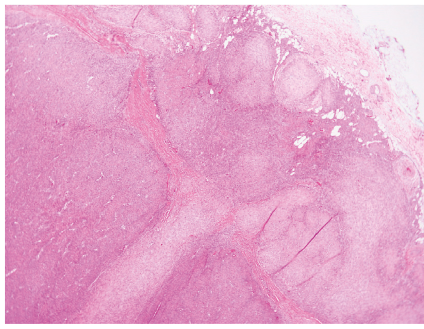
Figure 4: Low power view (5x magnification) shows a nodular/ multinodular tumor with a zonal appearance of hypercellular areas in the center and hypocellular areas at the periphery.